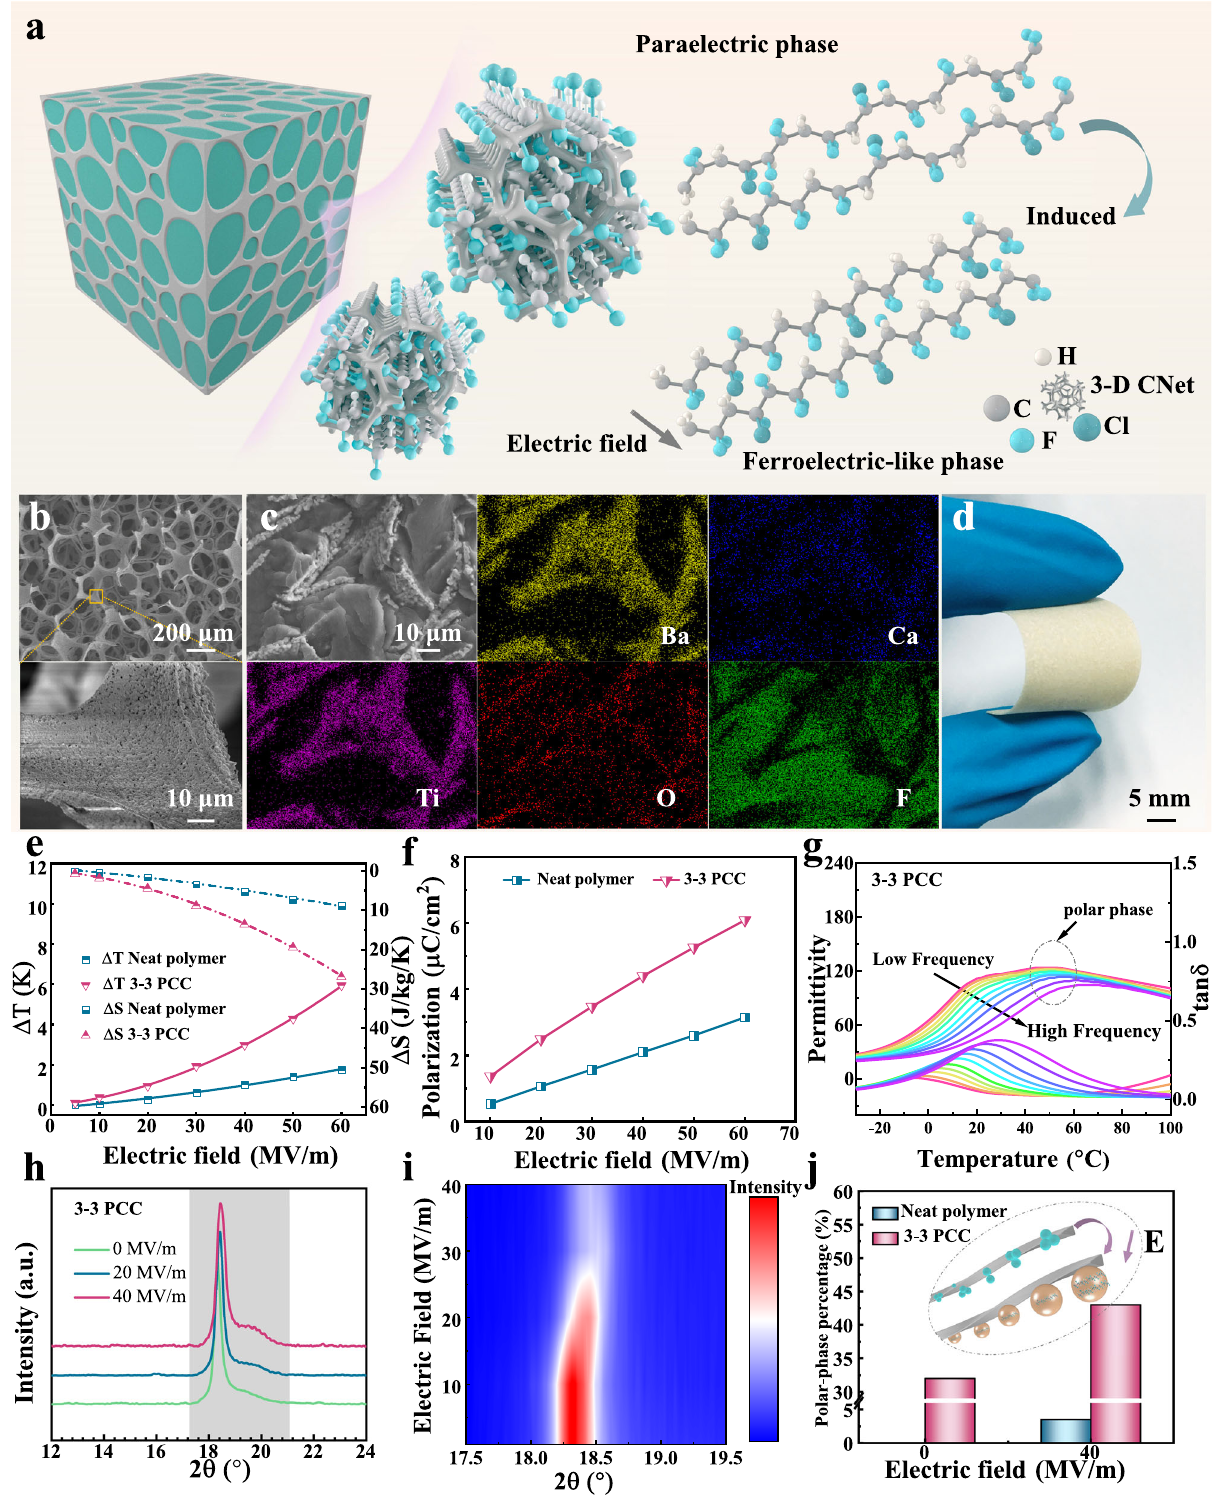
Fig. 1 | Structural origins of enhancing electrocaloric performance by 3-D thermally conductive networks. a Schematic diagram of inducing the transition fromparaelectric(nonpolar)toferroelectric-like(polar)phasesforthepolymerina restrictedstate-space. b SEMimagesof3-DCNet. c TheelementmappingofBa,Ca, Ti, O, and F, con fi rmed that the continuous 3-D CNet is implemented in 3-3 PCC. d Optical image of 3-3 PCC. e The Δ S and Δ T of the neat polymer and 3-3 PCC as a function of applied electric fi eld. f Polarization versus electric fi eld for the neat